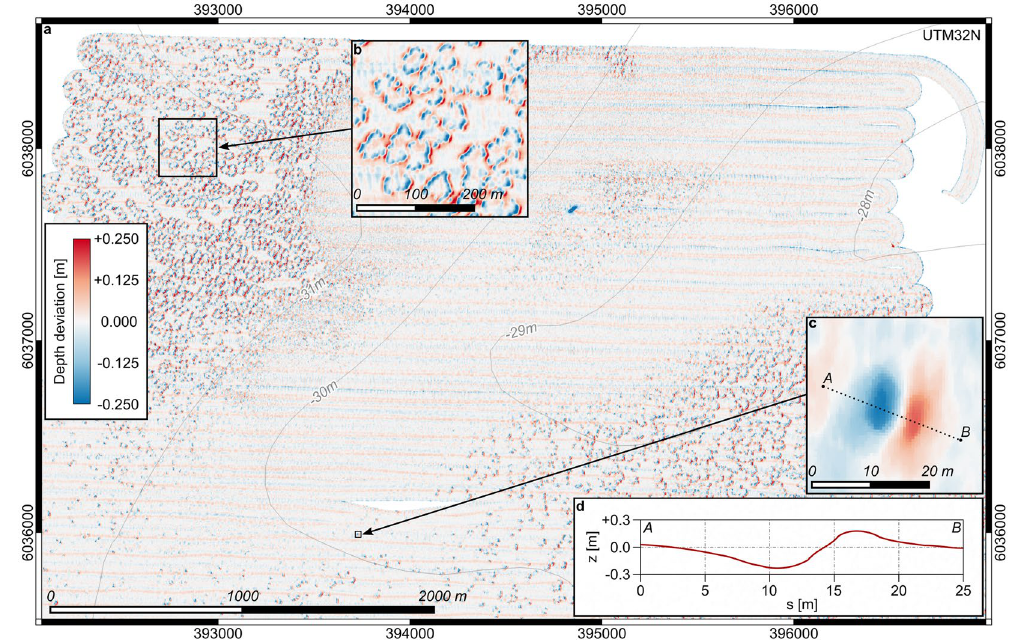
Figure 2. Pockmark density and morphology. ( a ) Zero-median bathymetry with full seafloor coverage from cruise HE470, August 2016. ( b ) Detail of pockmark cluster. ( c ) Detail of an individual pockmark. ( d ) Cross section along transect A–B. The maps were generated using QGIS Version 2.14.11 43 . Depth contours were made available by the GPDN project 44